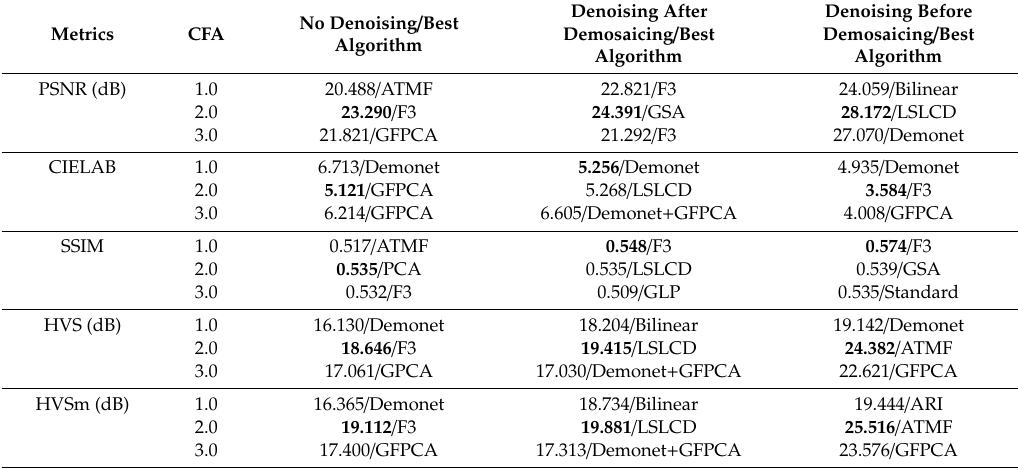
Table 3. Comparison of CFA patterns for the various demosaicing cases at 20 dBs SNR. Bold numbers indicate the best performing methods in each